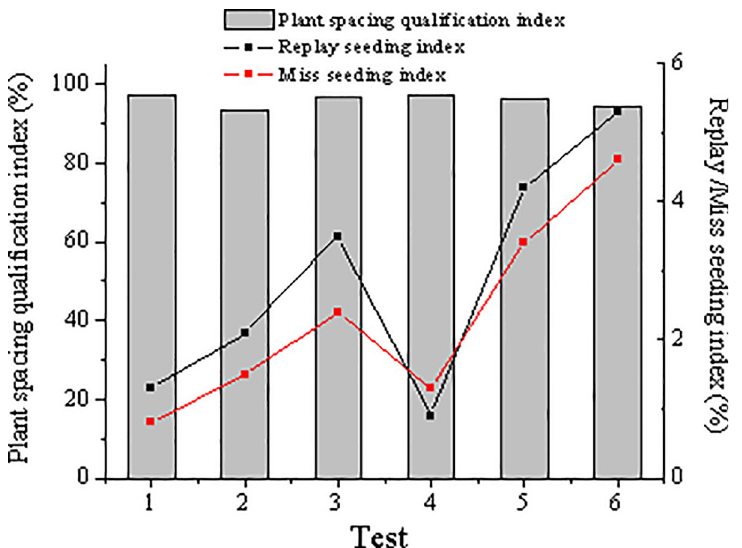
Fig 10. Results of single-grain operation test